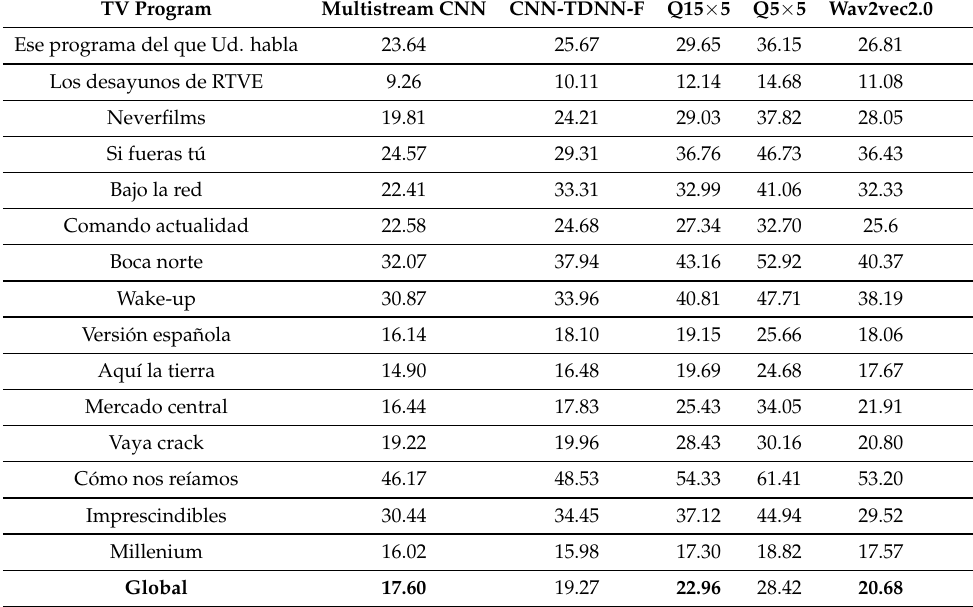
Table 5. Total WER of the ASR systems on each TV program of the RTVE2020 test set. TV